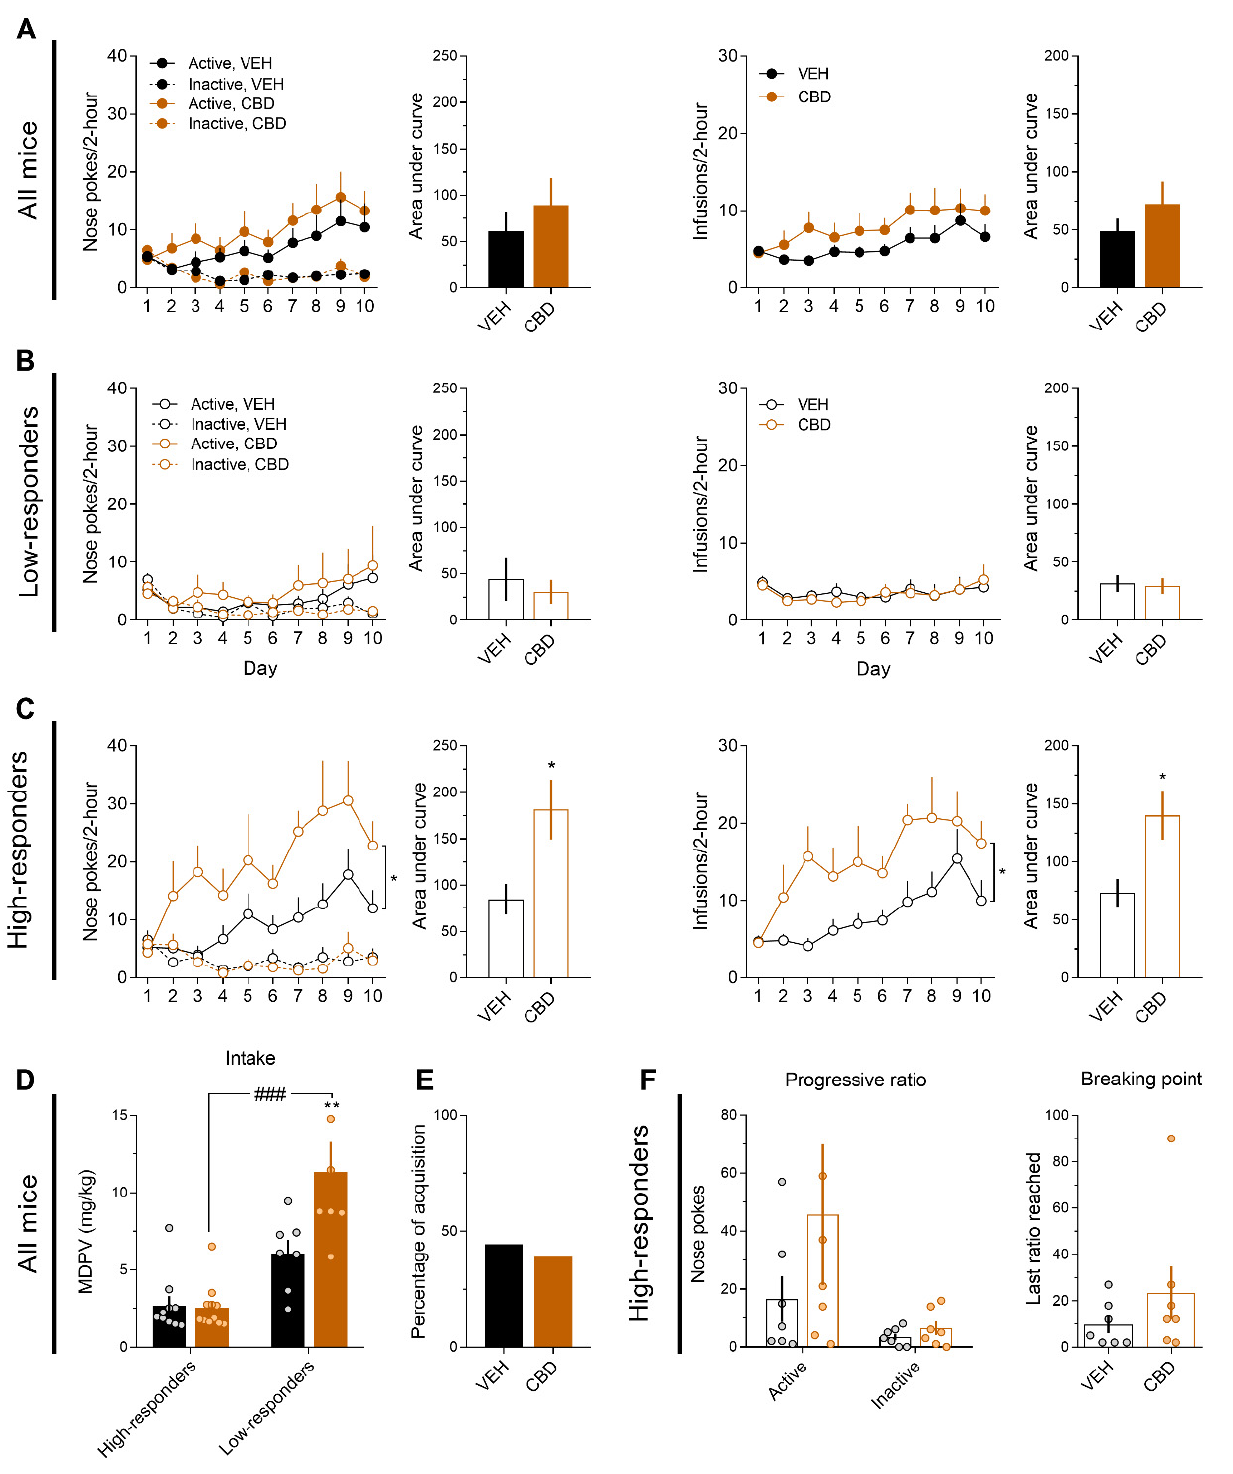
Figure 3. CBD increases MDPV (0.075 mg/kg/infusion) self-administration only for high responder mice. ( A ) Nose pokes and infusions along the self-administration days and their respective areas under the curve (VEH, n = 17; CBD, n = 18). ( B ) Nose pokes and infusions along the self-administration days and their respective areas under the curve for low-responders (VEH, n = 10; CBD, n = 11). ( C ) Nose pokes and infusions along the self-administration days and their respective areas under the curve for high-responders (VEH, n = 7; CBD, n = 7). Three-way ANOVA, * p < 0.05; Two-way ANOVA, * p < 0.05; Student’s t test, * p < 0.05. ( D ) Total MDPV intake. Bonferroni, ### p < 0.001, ** p < 0.01 vs vehicle low-responders. ( E ) Percentage of acquisition. ( F ) Active/inactive nose pokes and breaking point during the progressive ratio test.